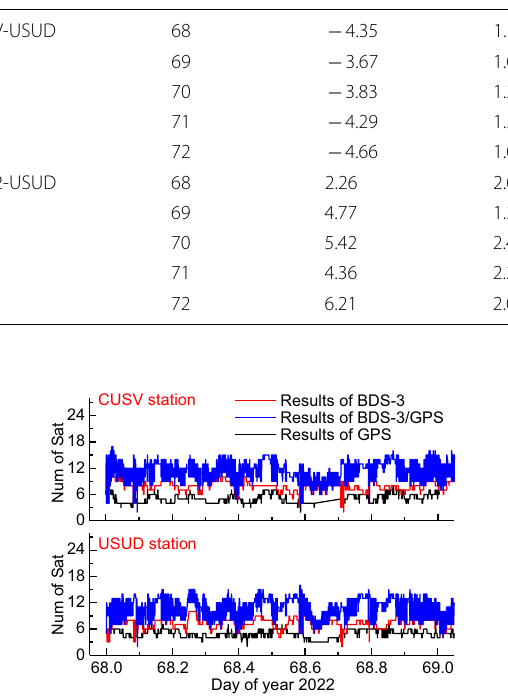
Fig. 6 Number of satellites used in the PPP processing for CUSV and USUD stations on DOY 68, 2022